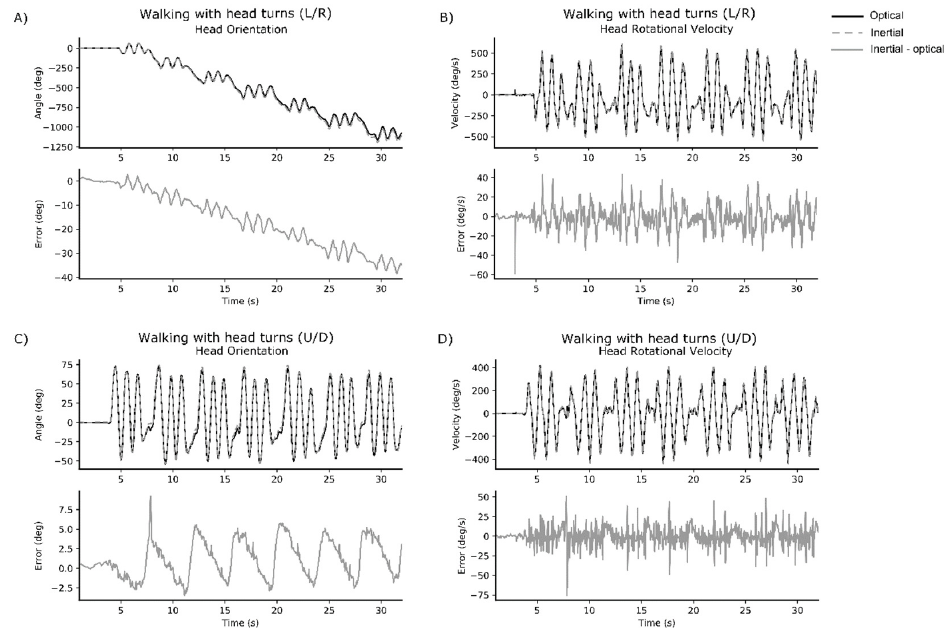
Figure 1. Representative time series data from one healthy participant. Each subplot provides the optical signal (black solid line) and IMU signal (grey dashed line) overlaid in the upper figure, and the error between optical and IMU signal below (grey solid line). Subplots represent: ( A ) head orientation for walking with head turns (L/R); ( B ) peak rotational velocity of the head for walking with head turns (L/R); ( C ) head orientation for walking with head turns (U/D); and ( D ) peak rotational velocity of the head for walking with head turns (U/D).